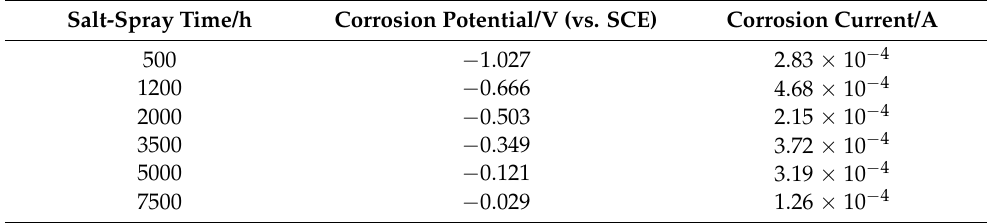
Table 2. Fitting data of polarization curves for inorganic zinc-rich coating after different salt-spray time.